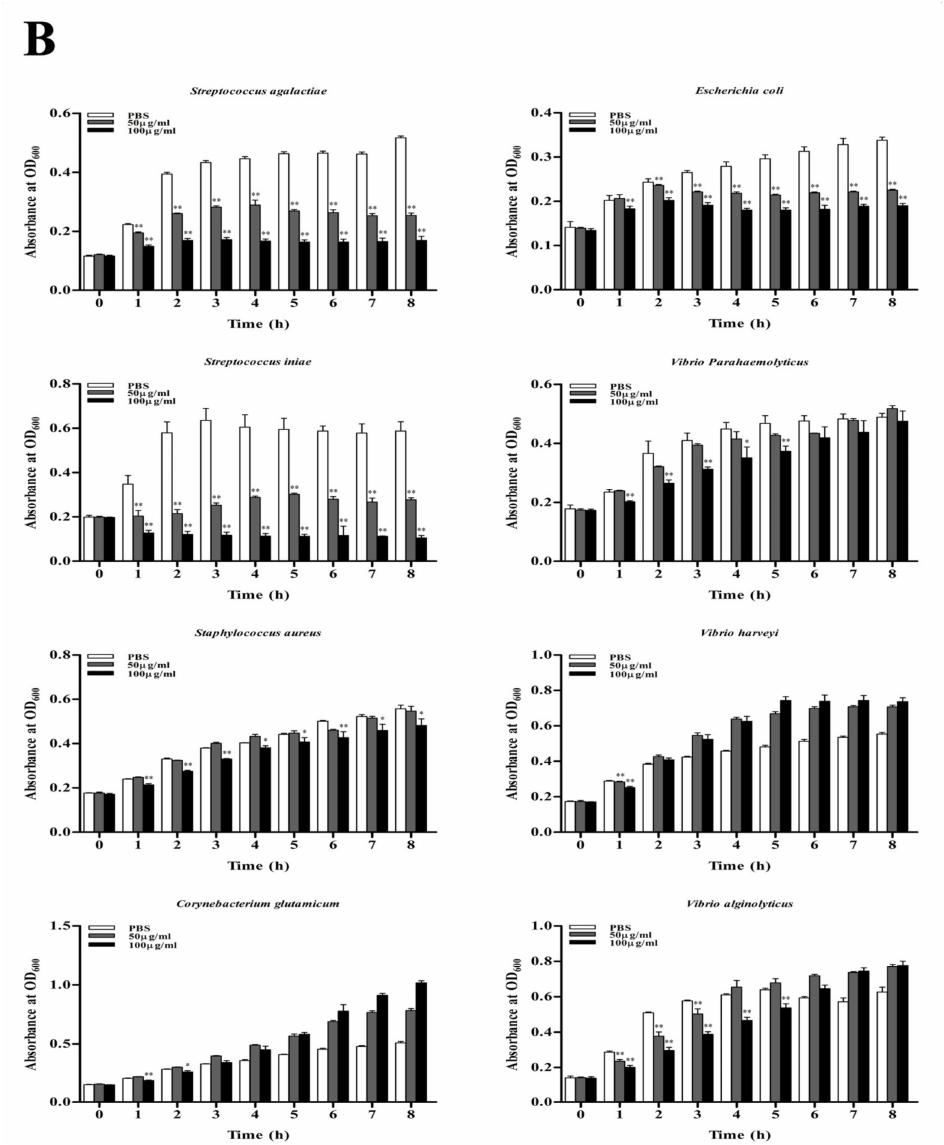
Figure 7. Bacteriostasis of rToBPI1/LBP ( A ) and rToBPI1/LBP ( B ) against Gram-positive bacteria S. agalactiae , S. iniae , S. aureus and C. glutamicum as well as Gram-negative bacteria E. coli , V. para- haemolyticus , V. harveyi and V. alginolyticus at 50 µ g/mL and 100 µ g/mL. Gram-positive bacteria are on the left panel, whereas Gram-negative bacteria are on the right. The data shown are the average of three independent experiments. The difference was significant when * p < 0.05, highly significant when ** p <